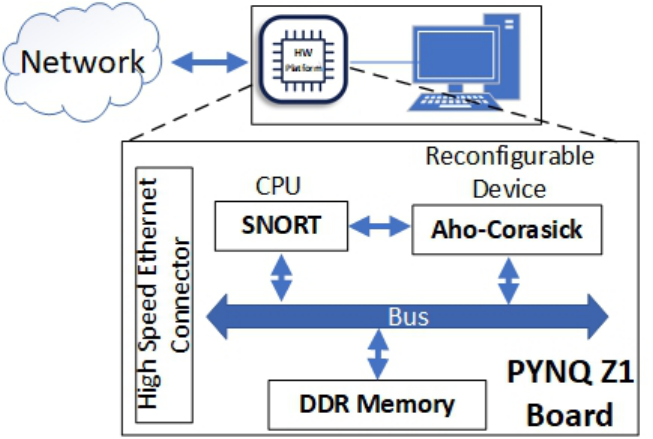
Figure 5. Reconfigurable Aho–Corasick architecture is integrated with the official Snort IDS on a PYNQ Z1